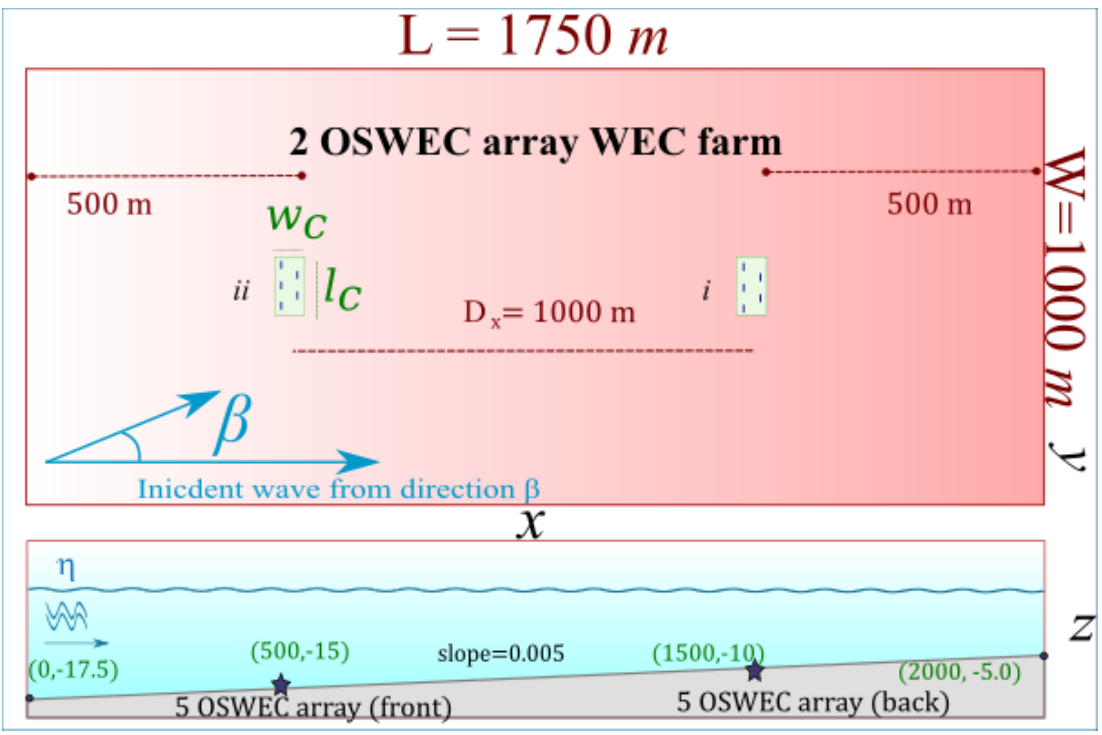
Figure 10. Exploratory 10 WEC farm for validation of the wave-to-wire model. Top and side